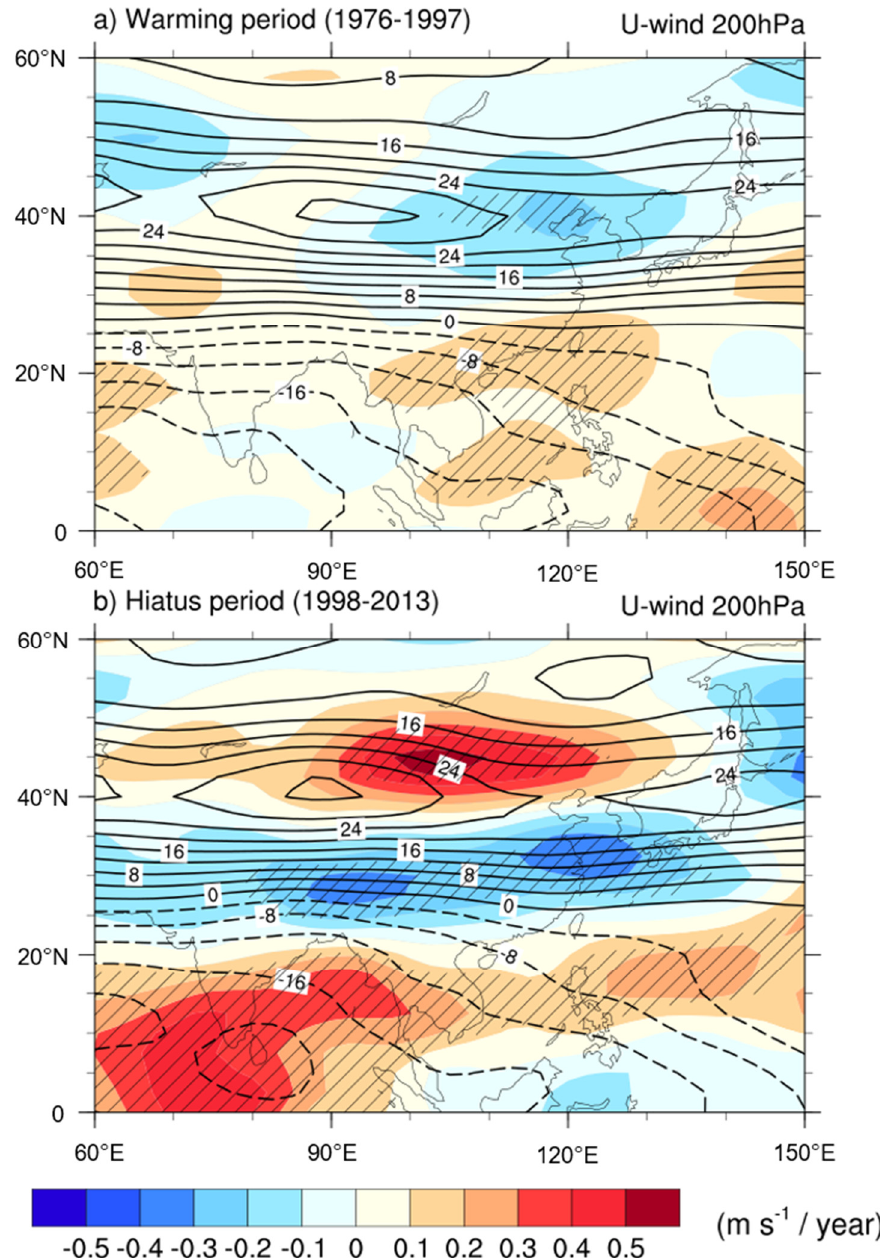
Figure 5. Same as Figure 3, but for zonal wind at 200 hPa.